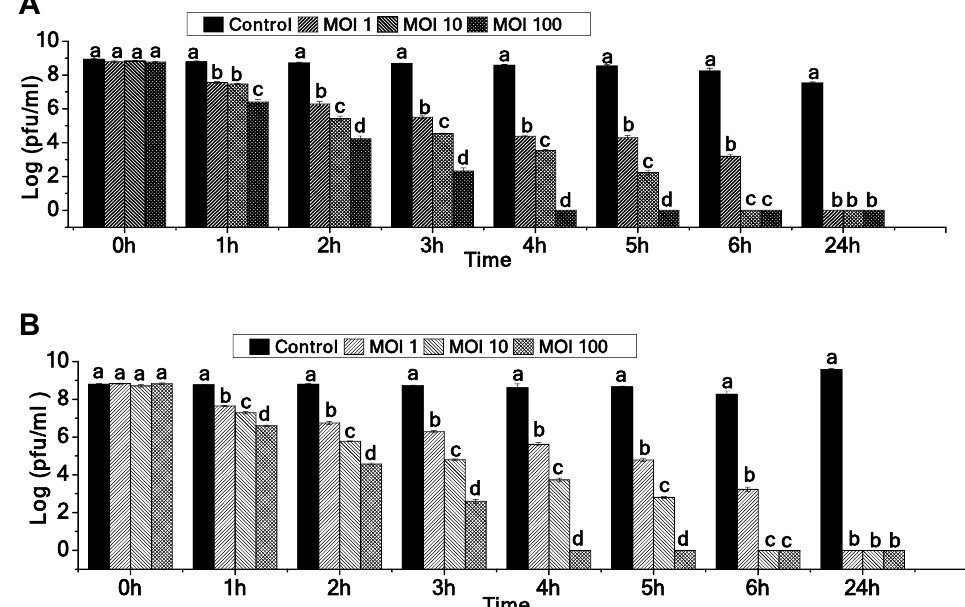
Figure 2. In-vitro assay of Shigella virus 2019SD1 against S. dysenteriae type 1 in ( A ) Saline and ( B ) Biodigester effluent. Error bar represents SEM (n = 3). Values of a given phage depicted as column without common letter differ significantly at p ≤ 0.05 as per the Tukey’s HSD